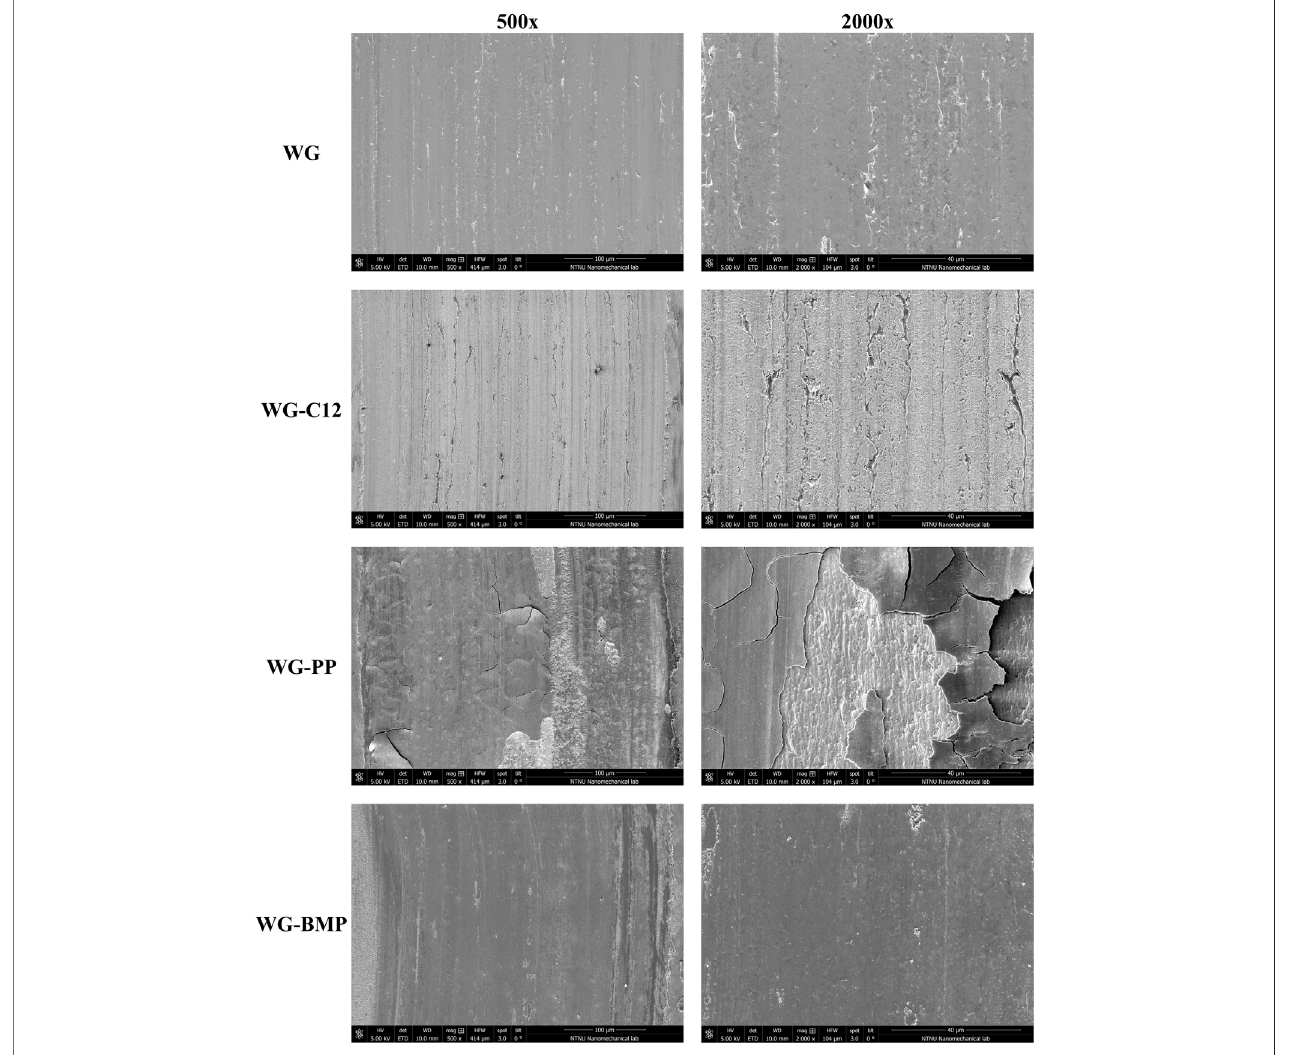
FIGURE 2 | SEM images of the wear tracks formed on the AISI 52100 steel disk tested in different lubricants at room temperature.